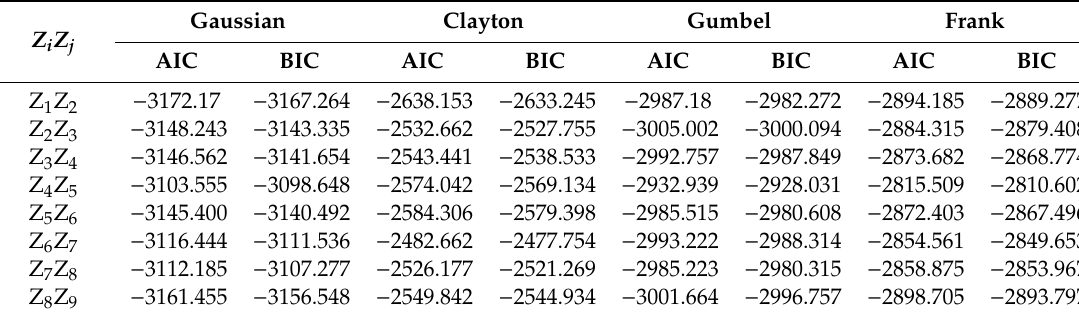
Table 9. The akaike information criterion (AIC) and bayesian information criterion (BIC) values for the candidate copulas.